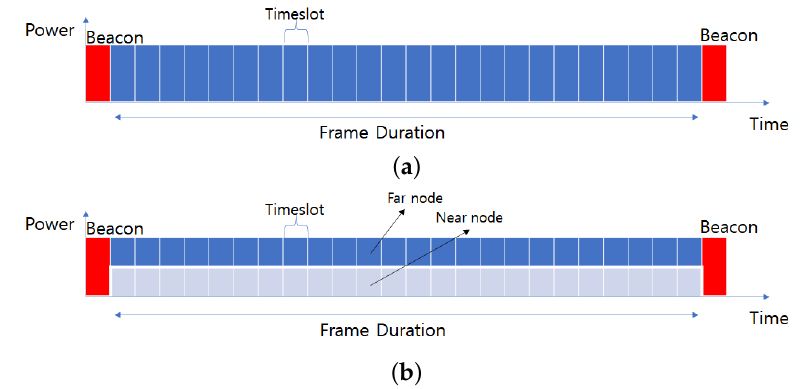
Figure 4. ( a ) OMA frame structure; ( b ) NOMA frame structure.